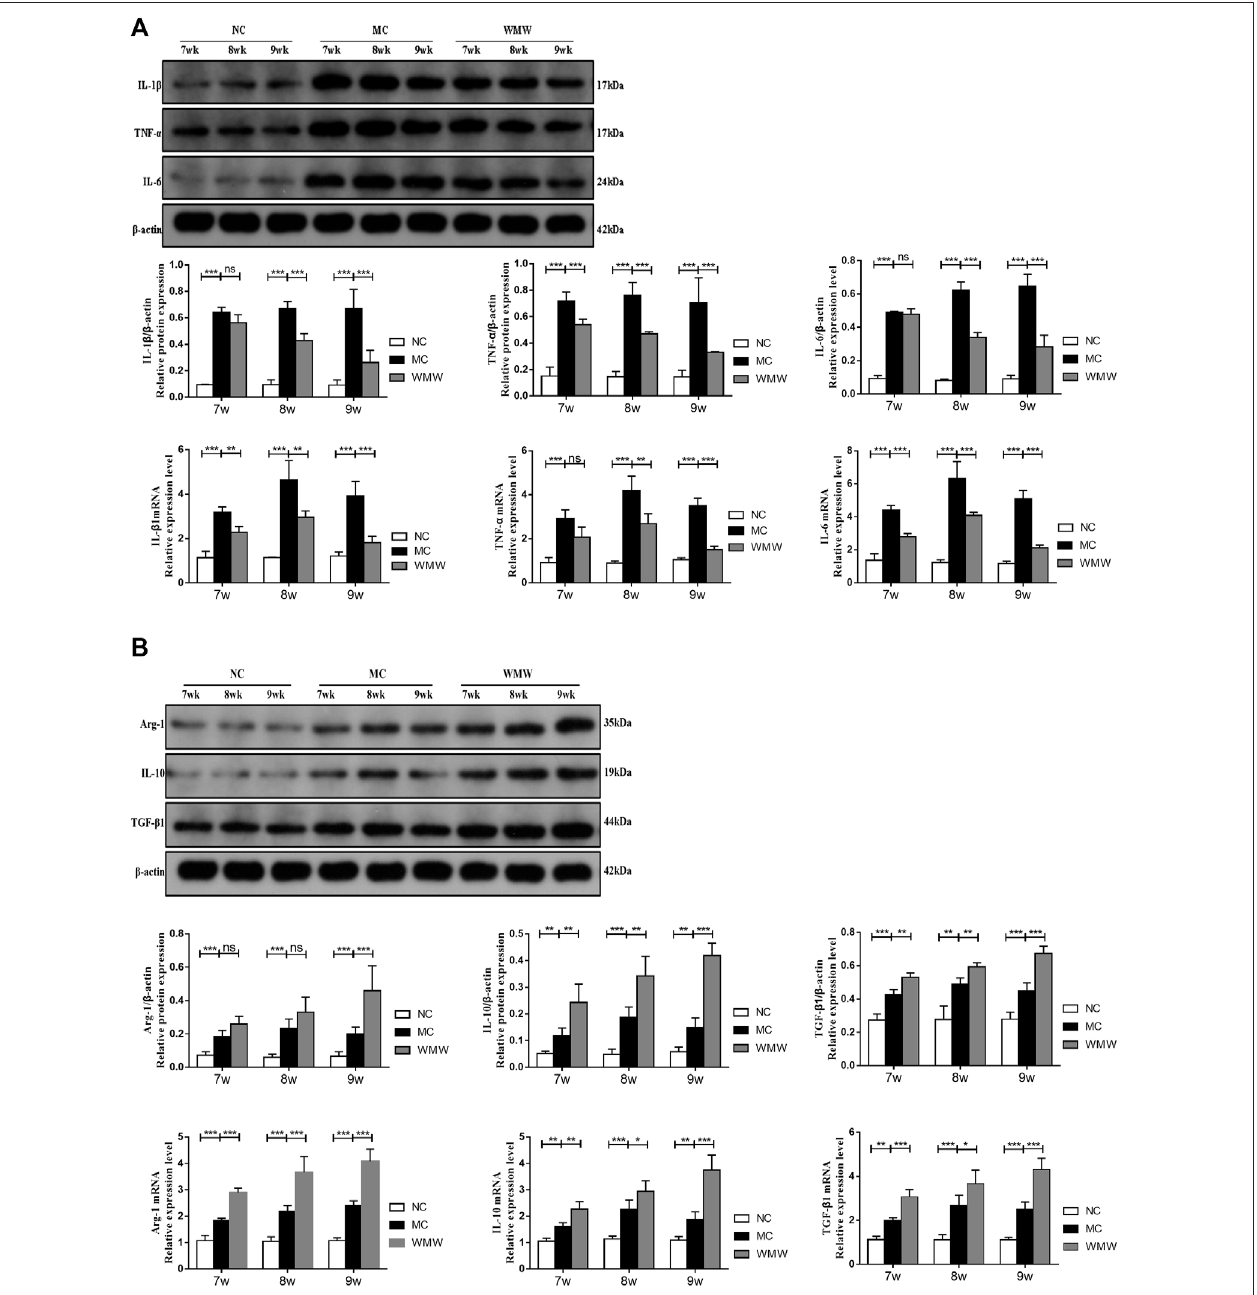
FIGURE 5 | WMW reduces colonic in fl ammatory responses in DSS-induced colitis. (A) Relative mRNA level of IL-1 β , IL-6, and TNF- α in the colon was measured through qPCR. Expression of IL-1 β , IL-6, and TNF- α in colon tissue lysates were determined by Western blot from DSS-challenged mice. (B) Relative mRNA level of IL- 10, Arg-1, and TGF- β 1in the colonwasmeasured through qPCR. Expression ofIL-10, Arg-1,and TGF- β 1 incolon tissue lysates were determined by Western blot from DSS-challenged mice. n = 3,.means ± SEM.* p < 0.05, ** p < 0.01, *** p < 0.001.